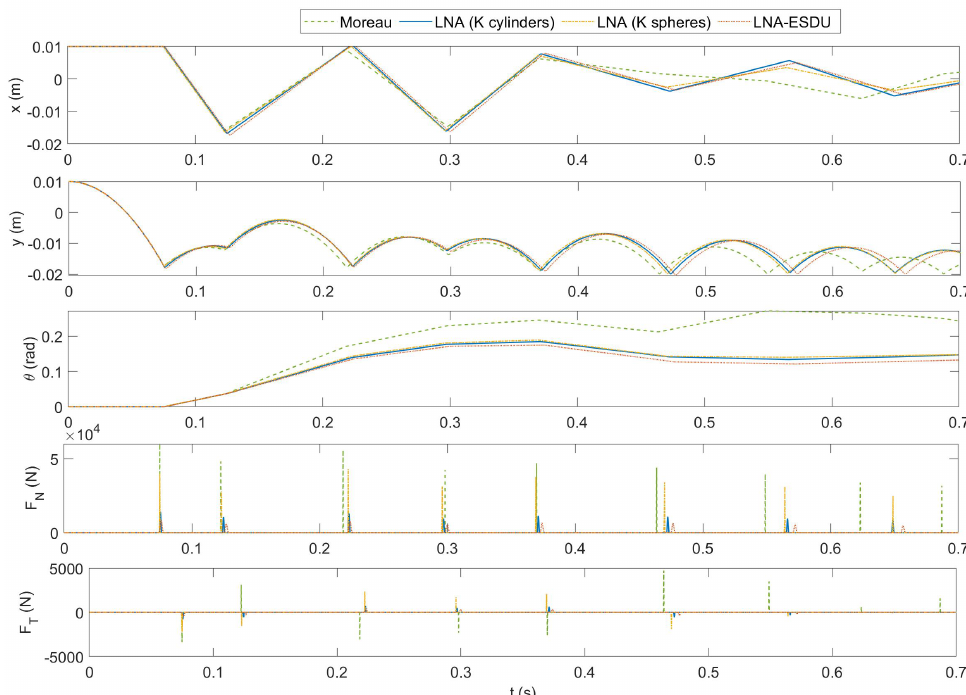
Figure 8. Model comparison considering an asymmetrical impact: from the top to the bottom: x - coordinate of G 1 , y -coordinate of G 1 , rotation angle θ of body 1, normal contact force F N , tangential friction force F T